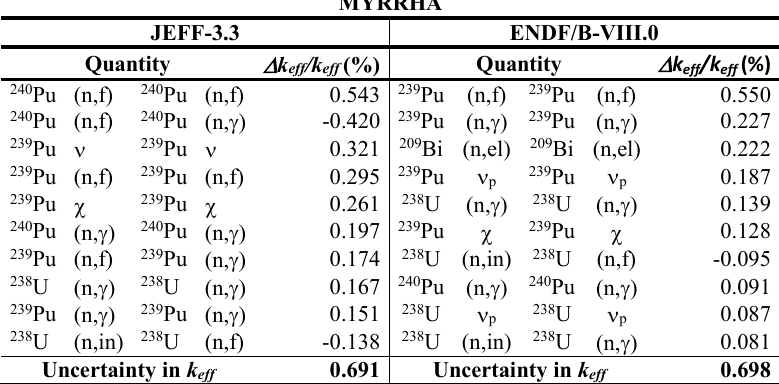
Table 2. UQ for MYRRHA using different covariance